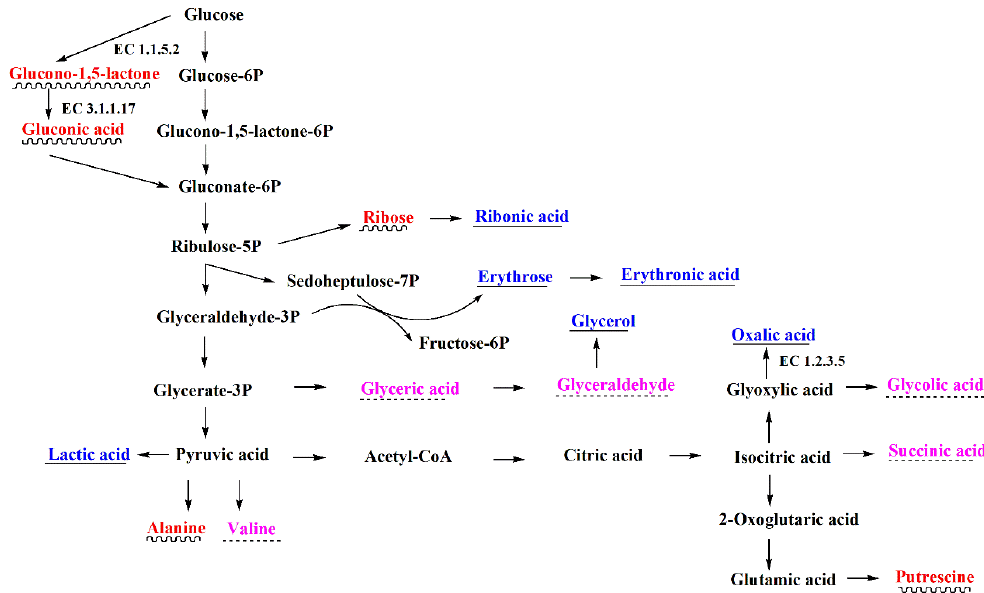
Figure 2. The primary metabolism showing the major compounds that were detected in P. fluorescens gim-3. The red-labeled and wavy-line-underscored metabolites are those in large quantities. The blue-labeled and straight-line-underscored metabolites are those in moderate quantities. The purple-labeled and dotted-line-underscored metabolites are those in small quantities.